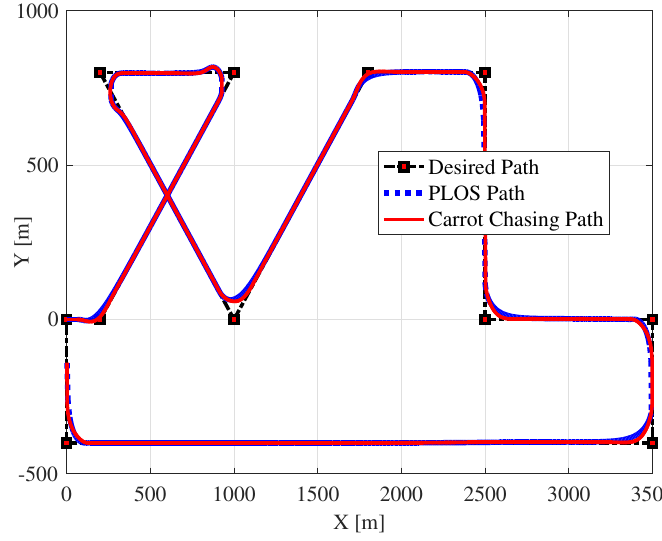
Figure 23. Straight line path following without wind.